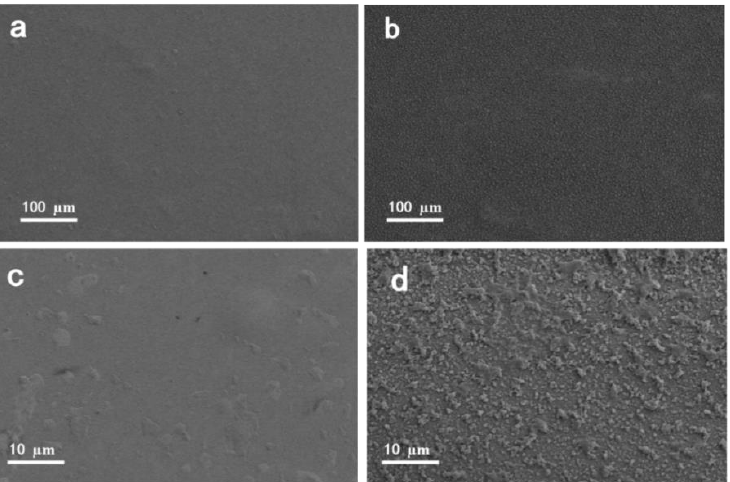
Figure 7. SEM of membrane surface (( a , c ) ZrO 2 /BCM; ( b , d ) IP–ZrO 2 /BC–NFM).